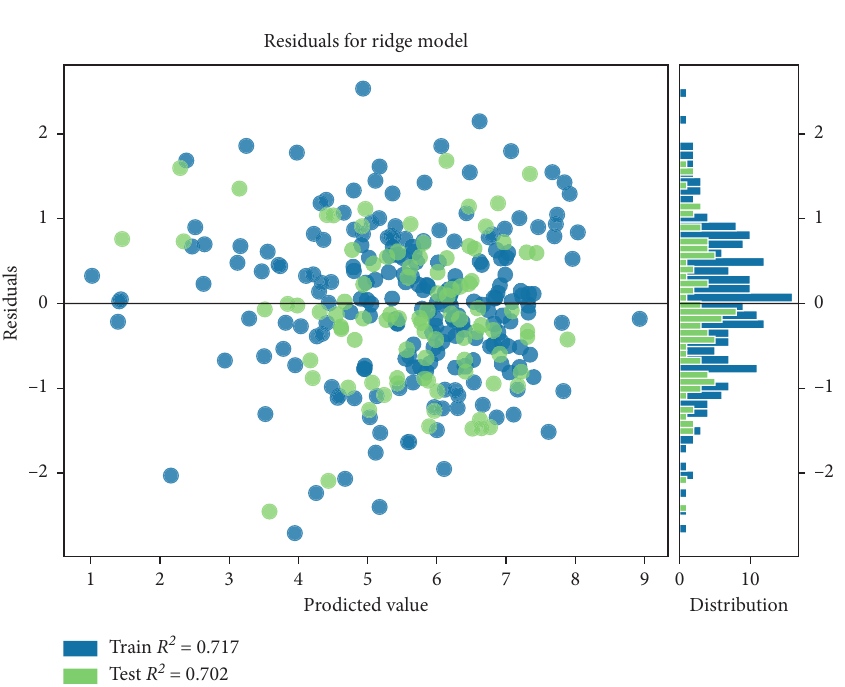
Figure 13: Residuals for ridge